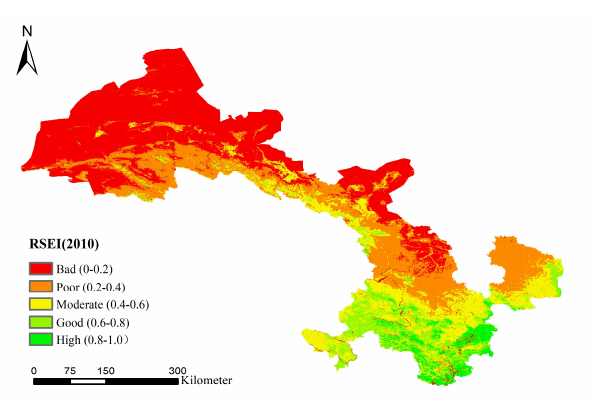
Figure 4 . Distribution of RSEI ratings of Gansu Province in 2010.